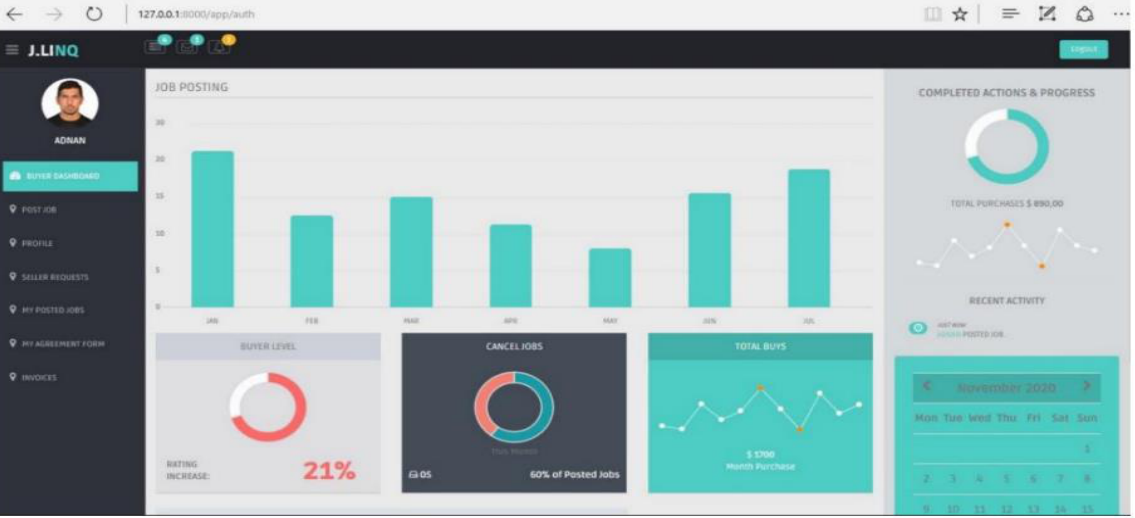
Figure 13. Job posting interface of the system.